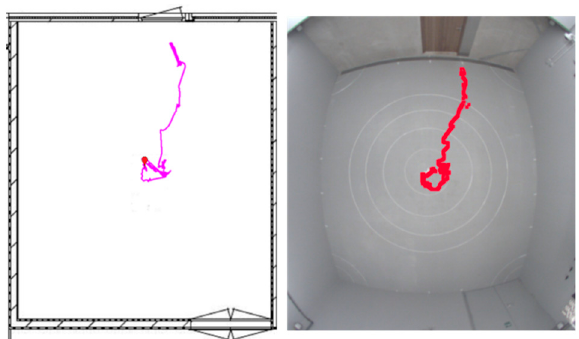
Figure 2. Tracking an individual laying hen using ultra-wideband (UWB) tracking (left panel) and video tracking (right panel).